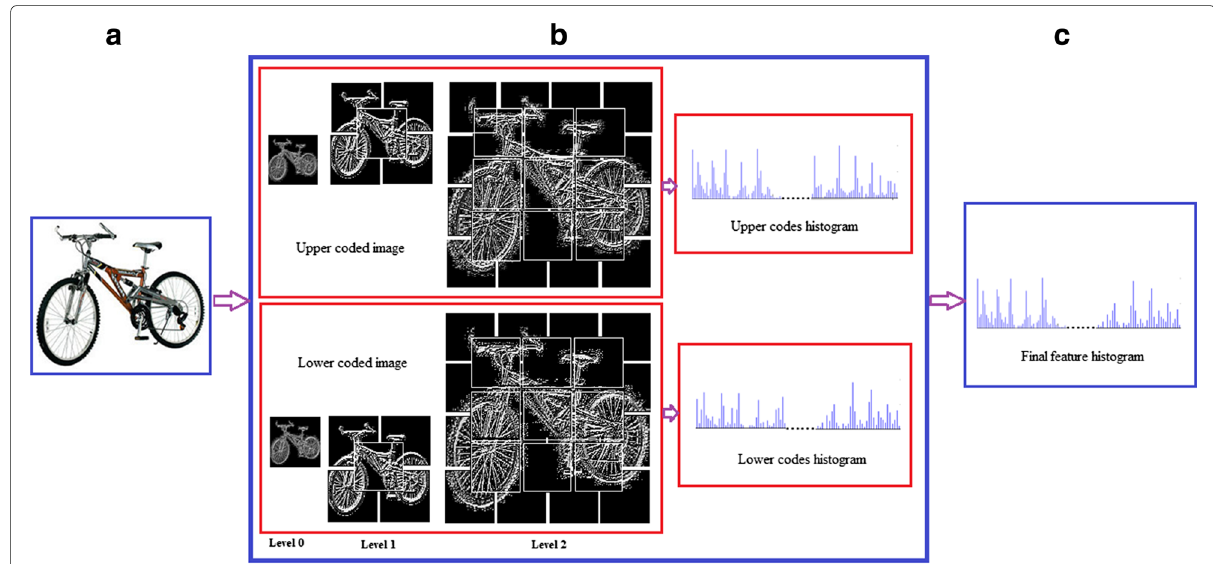
Fig. 5 Overall process of DTCTH calculation. a Input image. b DTCTH codes in overlapping SPM. c Final feature histogram